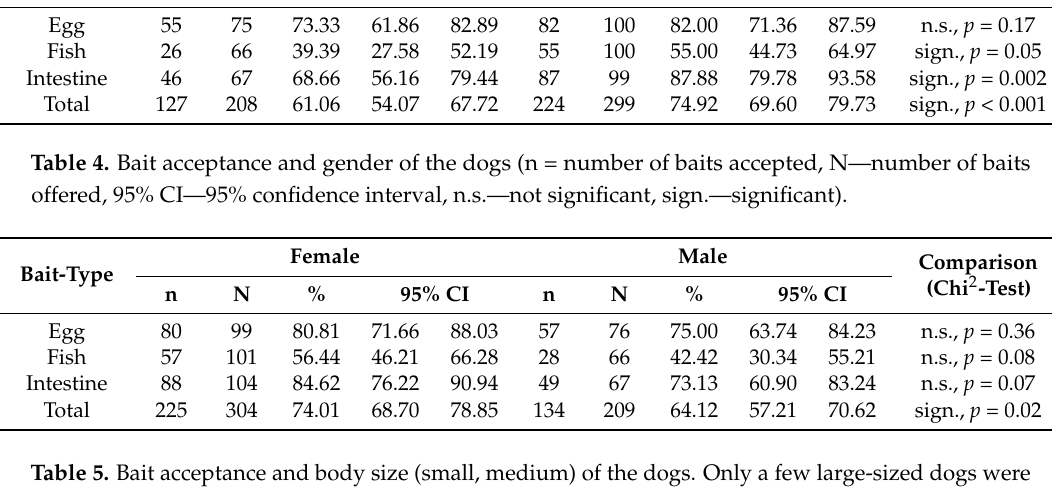
Table 3. Bait acceptance and the ownership status (street dogs, temple dogs) of the dogs. Only a few owned and feral dogs were included in the study and therefore they were not included in the analysis (n = number of baits accepted, N—number of baits offered, 95% CI—95% confidence interval, n.s.—not significant, sign.—significant).